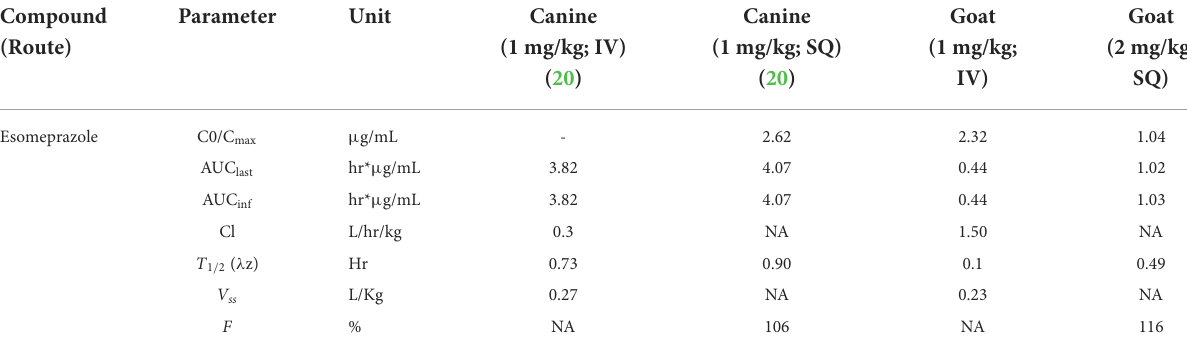
TABLE 3 Comparison of the PK parameters reported from the canine literature and the caprine subjects of this study. Compound